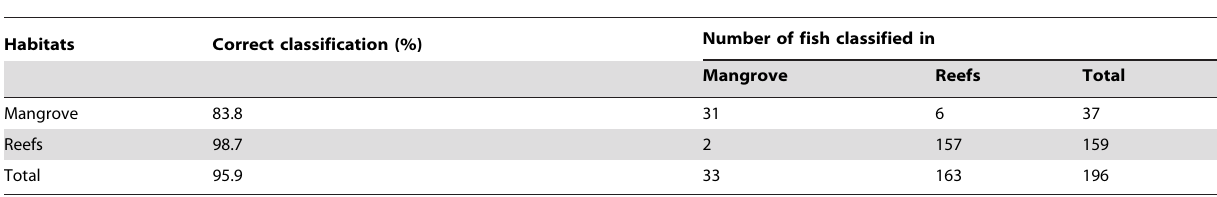
Table 2. Classification matrix of habitats obtained from Random Forest analyses.